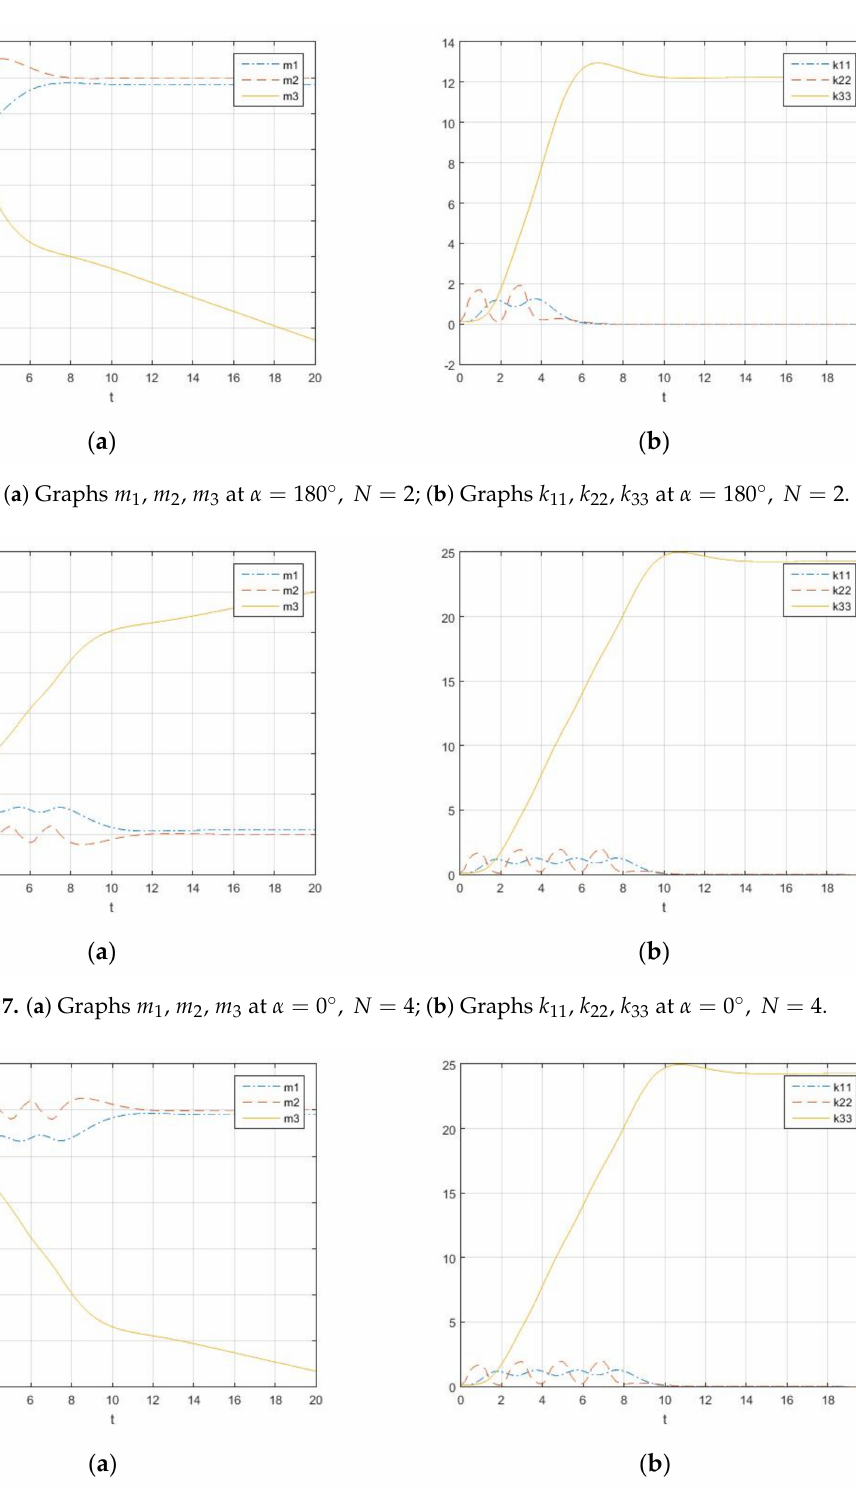
Figure 8. ( a ) Graphs m 1 , m 2 , m 3 at α = 180 ◦ , N = 4; ( b ) Graphs k 11 , k 22 , k 33 at α = 180 ◦ , N =